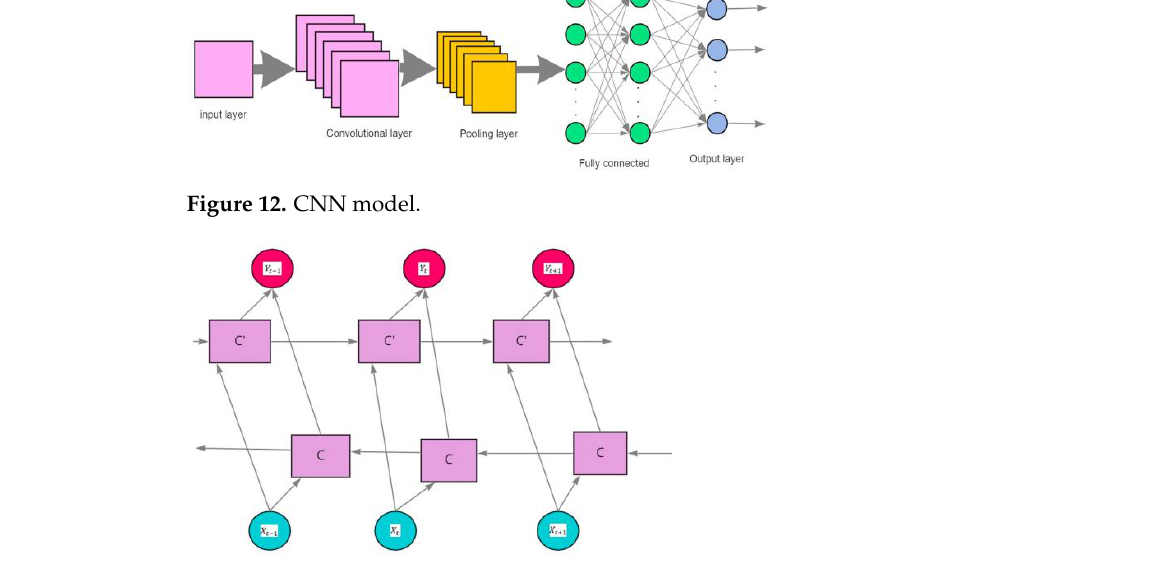
Figure 13. Bidirectional LSTM model.